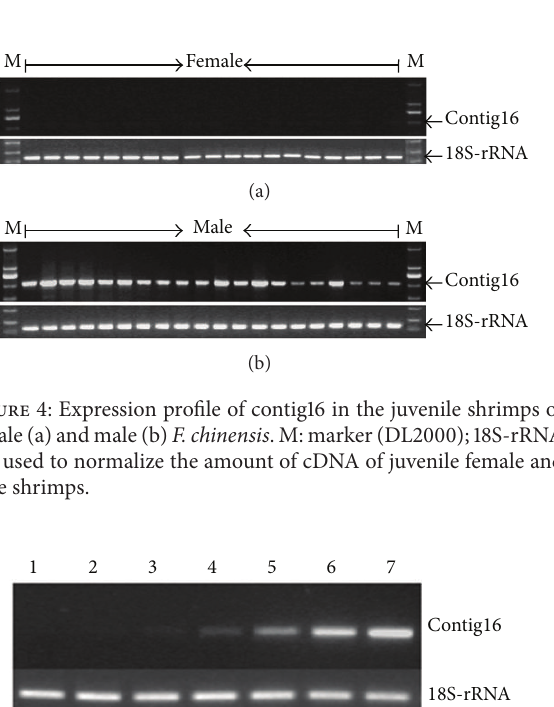
Figure 3: Expression profile of the selected genes in the cephalothoraxes of female and male shrimps F. chinensis . C (14): contig; M: marker (DL2000); 18S-rRNA was used to normalize the amount of cDNA of female and male shrimps’ cephalothoraxes.